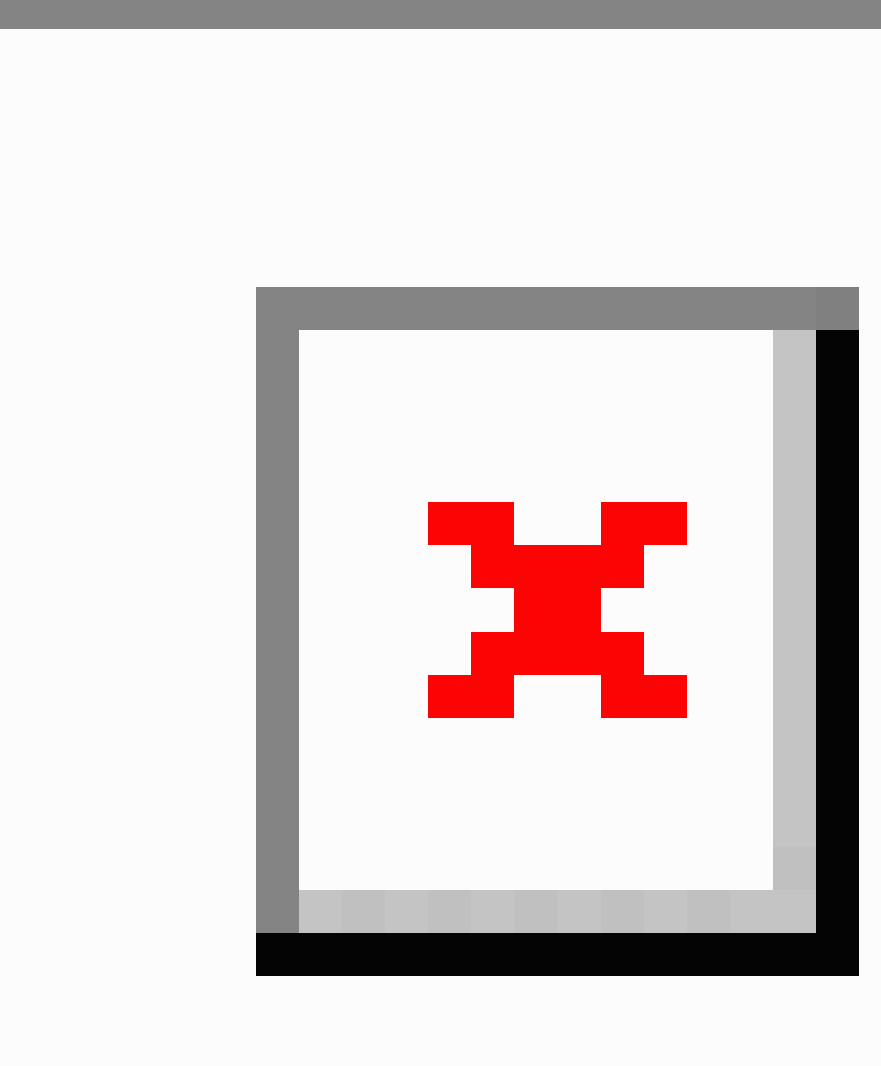
Figure 1. Screenshot of example baseline data